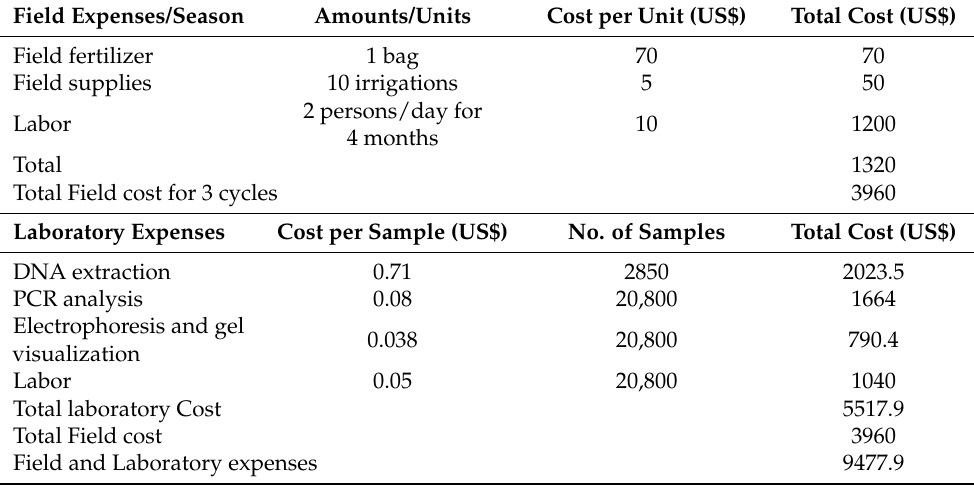
Table 1. The field and laboratory work cost associated with the combined marker-assisted backcross- ing